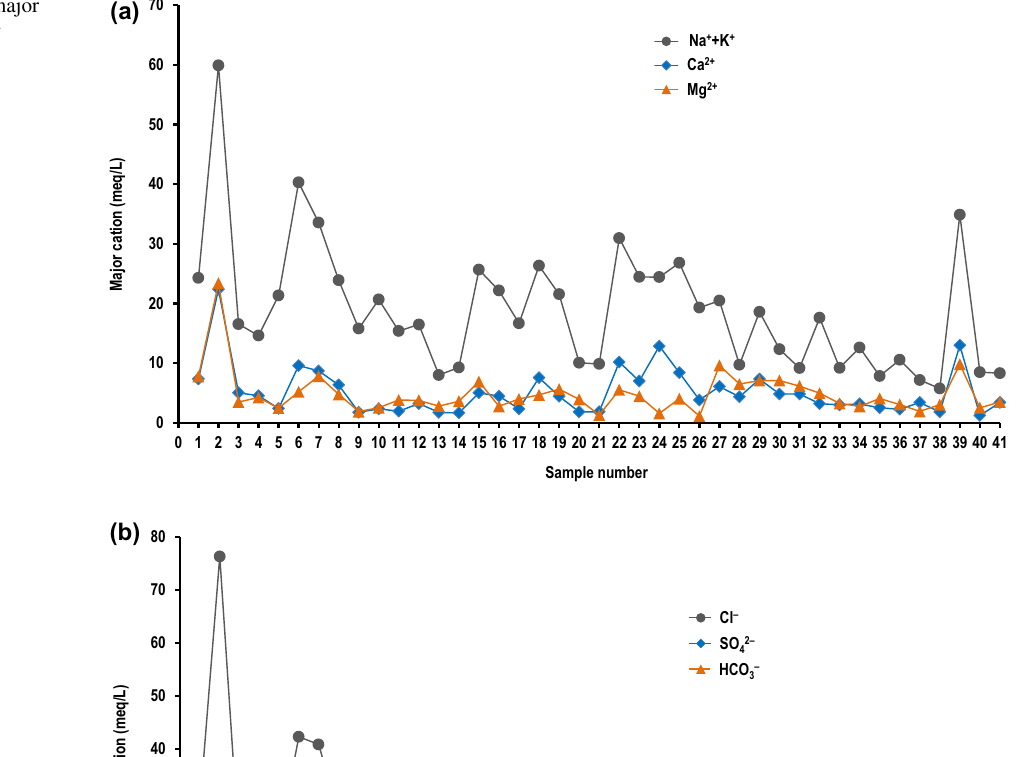
Fig. 3 Concentrations of major ions in the study area a for cations and b for anions